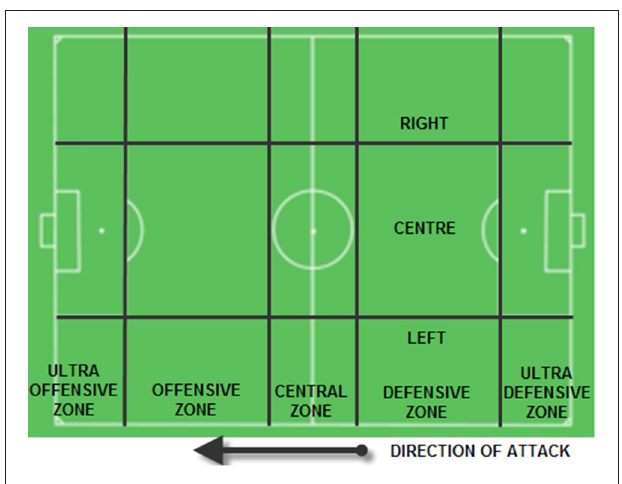
FIGURE 2 | Zones and lateral positions. Adapted from Camerino et al.